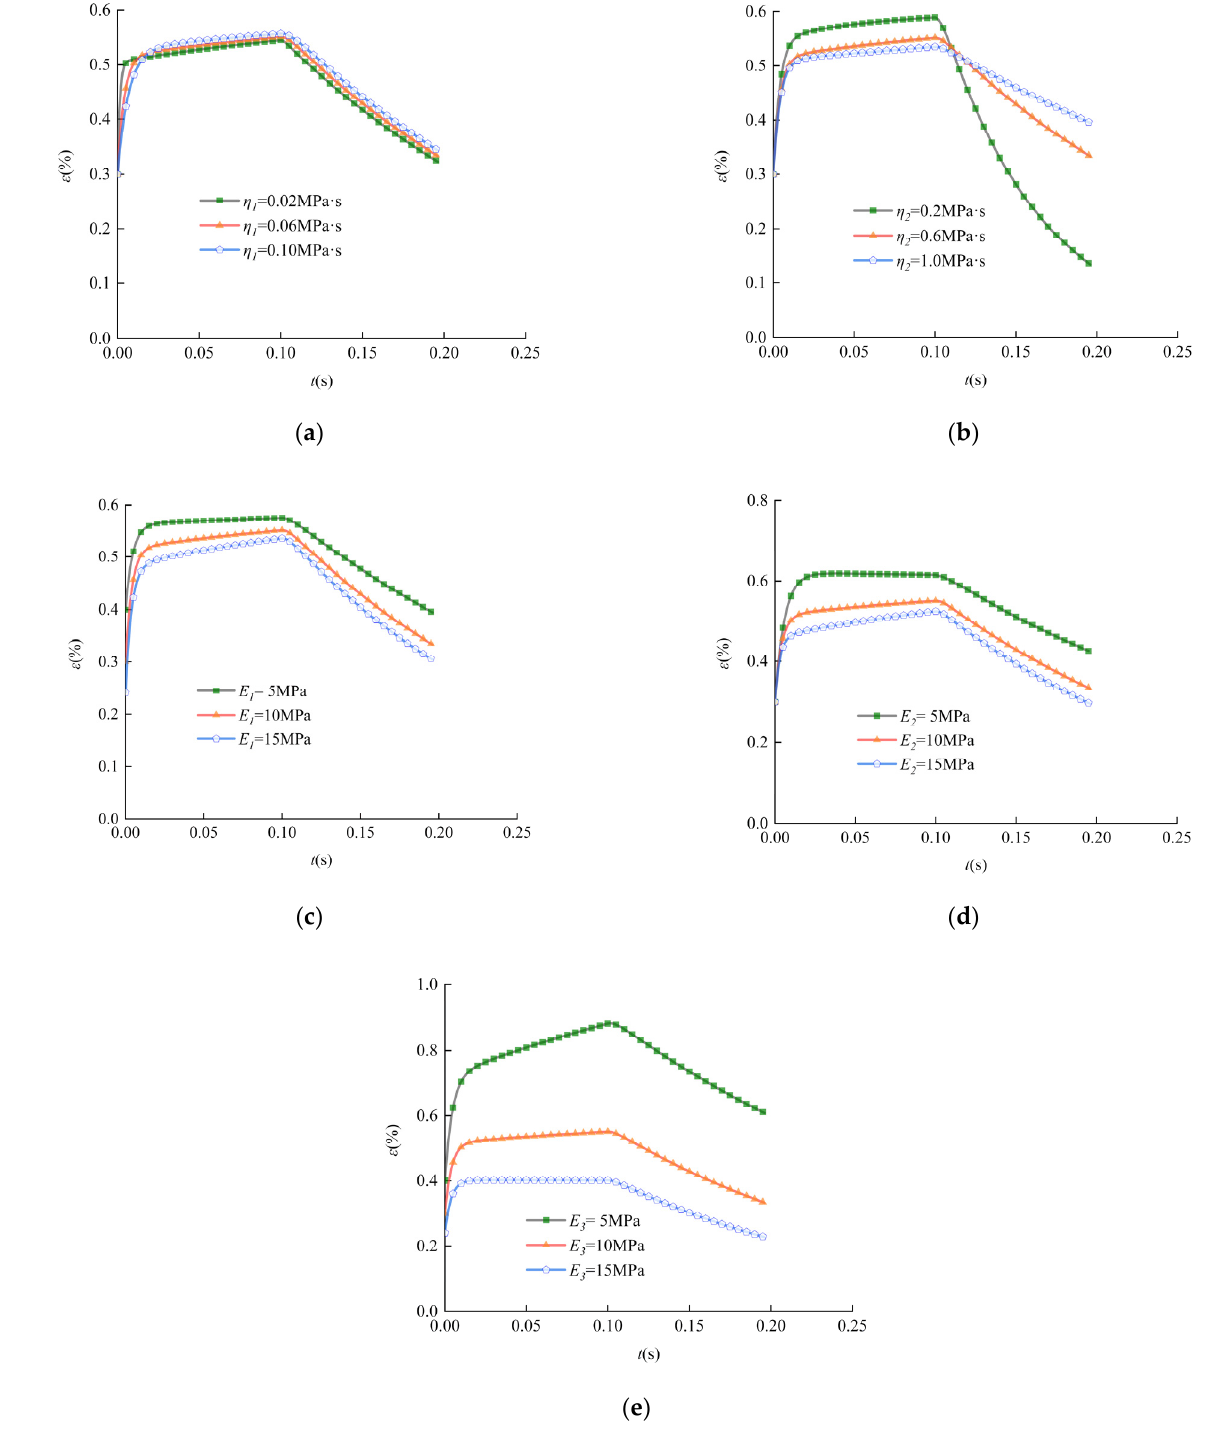
Figure 6. The rheological curves under different parameters. ( a ) Changing η 1 ; ( b ) changing η 2 ; ( c ) changing E 1 ; ( d ) changing E 2 ; ( e ) changing E 3